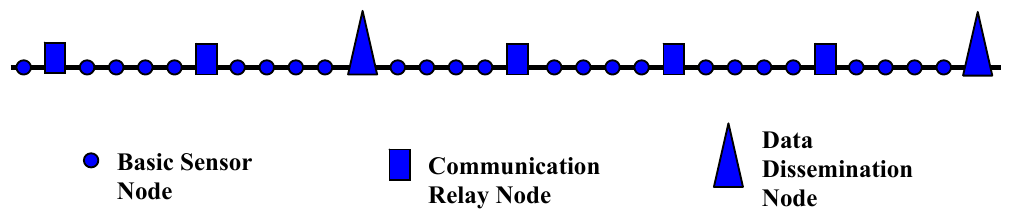
Figure 10. A representation of a three-level hierarchical sensor network